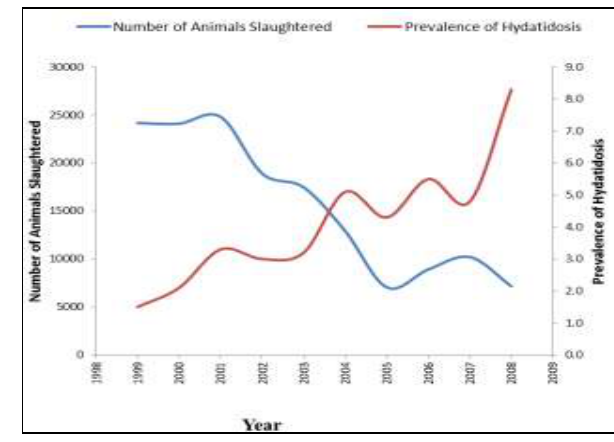
Figure-1: Trend of the number of animals slaughtered in ten years time (1998 -2010).